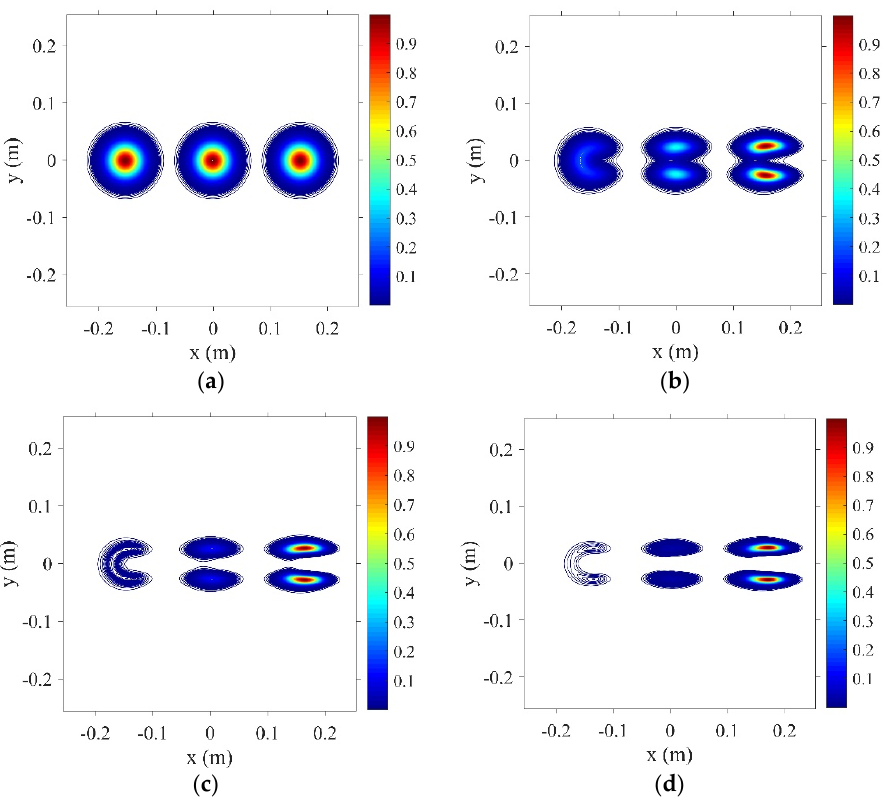
Figure 2. Thermal blooming of three − channel incoherent beams arranged along the direction of wind, where ( a ) Initial arrangement; ( b ) N c = 0.5; ( c ) N c = 1.0 and ( d ) N c = 1.5. The thermal blooming of seven incoherent beams arranged as a circle is shown in Figure 3. It can be seen that the arrangement can be regarded as superposition of the fun ‐ damental combination in Figures 1 and 2. The two beams in the top and bottom lines are the same as in Figure 1. The arrangement of the three beams in the middle line is the same as in the Figure 2. ( d ) Figure 3. Thermal blooming of 7 − channel incoherent beams with ( a ) Initial arrangement; ( b ) N c = 0.5; ( c ) N c = 1.0 and ( d ) N c = 1.5.